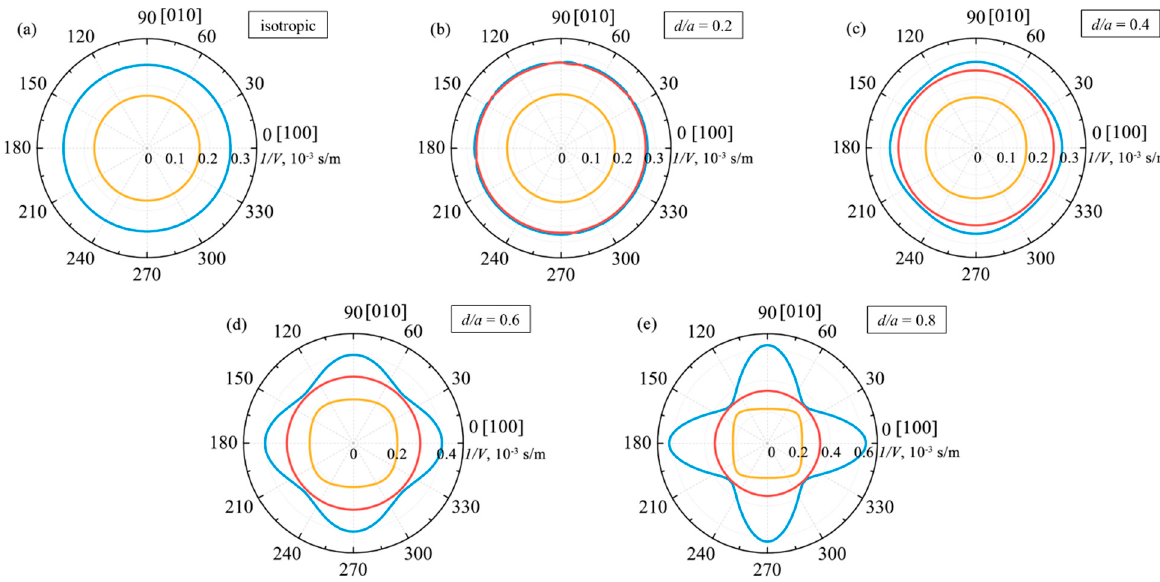
Figure 5. ( a ) Inverse phase velocity curves in the XY plane in an isotropic material of fused silica. Shown in ( b – e ) are inverse phase velocity curves of a phononic crystal with the normalized hole diameter: ( b ) d/a = 0.2; ( c ) d/a = 0.4; ( d ) d/a = 0.6; and ( e ) d/a = 0.8.